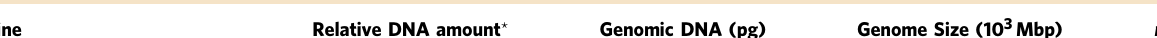
Table 2 | Genome size measurements.